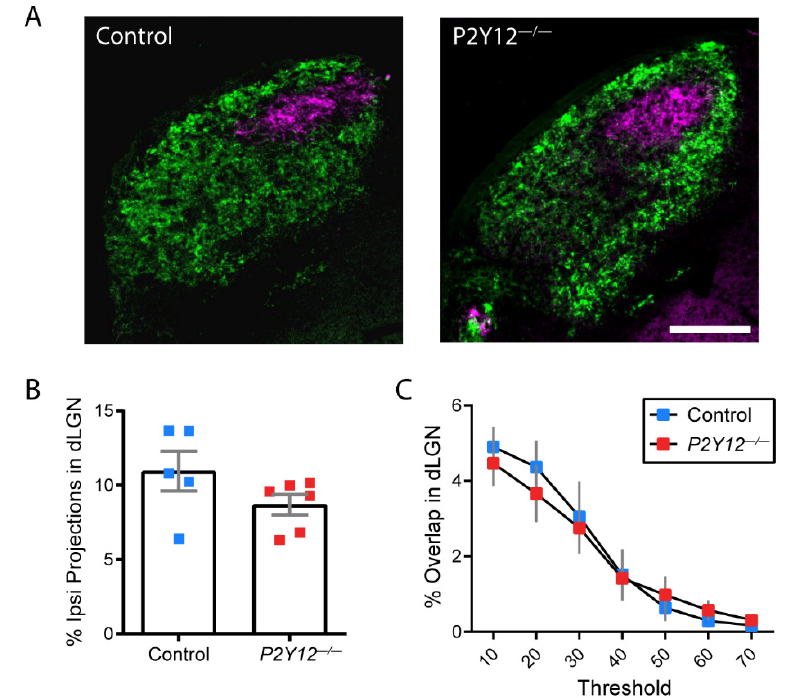
Figure 1. P2Y12 is not required for developmental retinogeniculate (RGC) reorganization in the lateral geniculate nucleus. (LGN): ( A ) representative images of contralateral (green) and ipsilateral (magenta) eye projections in the LGN of C57BL/6J and P2Y12 —/— mice at P29. Scale bar = 500 µm; ( B ) there is no significant difference in the proportion of ipsilateral eye projections in the dorsal LGN across genotypes; ( C ) there is no significant difference in the percent of overlap between ipsilateral and contralateral eye projections in the dorsal LGN across genotypes across a range of noise thresholds. ( B ): unpaired t -test, ( C ): two-way ANOVA; n = 5–6 mice per genotype; graphs show the mean +/ − SEM.